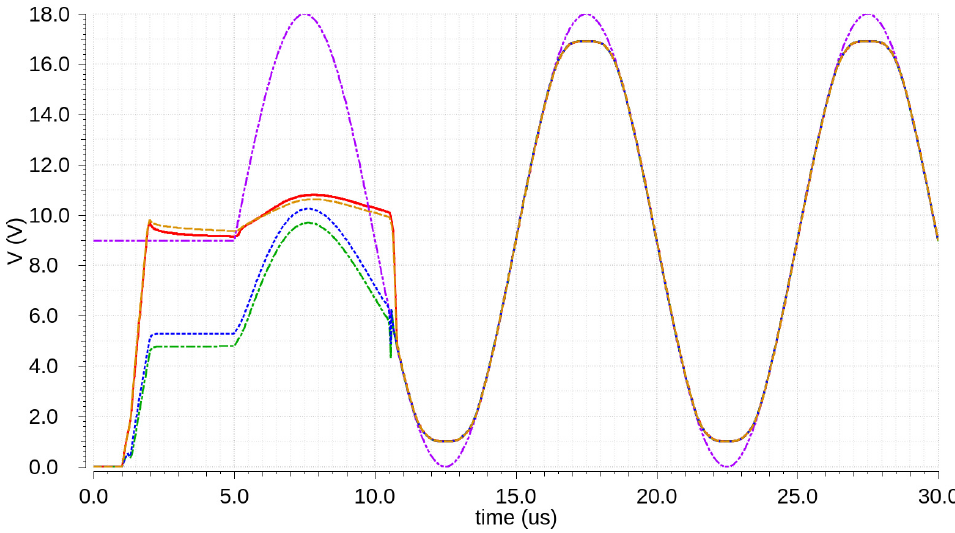
Figure 16. 100 kHz input sinusoidal waveform (violet dash-dash-dotted line) and comparison of the resulting output signals during the power-up sequence and normal operation; the original buffer— blue dotted line; the SOAC buffer—green dashed-dotted line; the laid-out original buffer—orange dashed line; the laid-out SOAC buffer—red solid